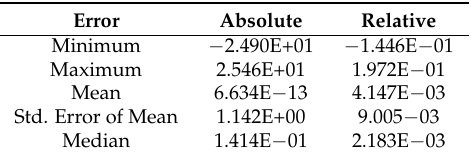
Table 5. V2V density estimation